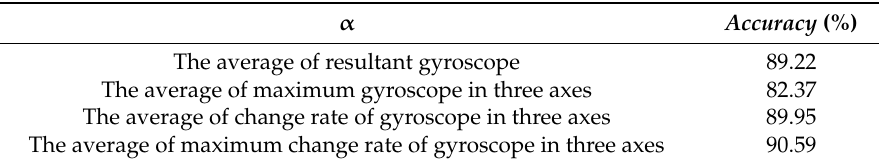
Table 4. Result of comparison between different values.